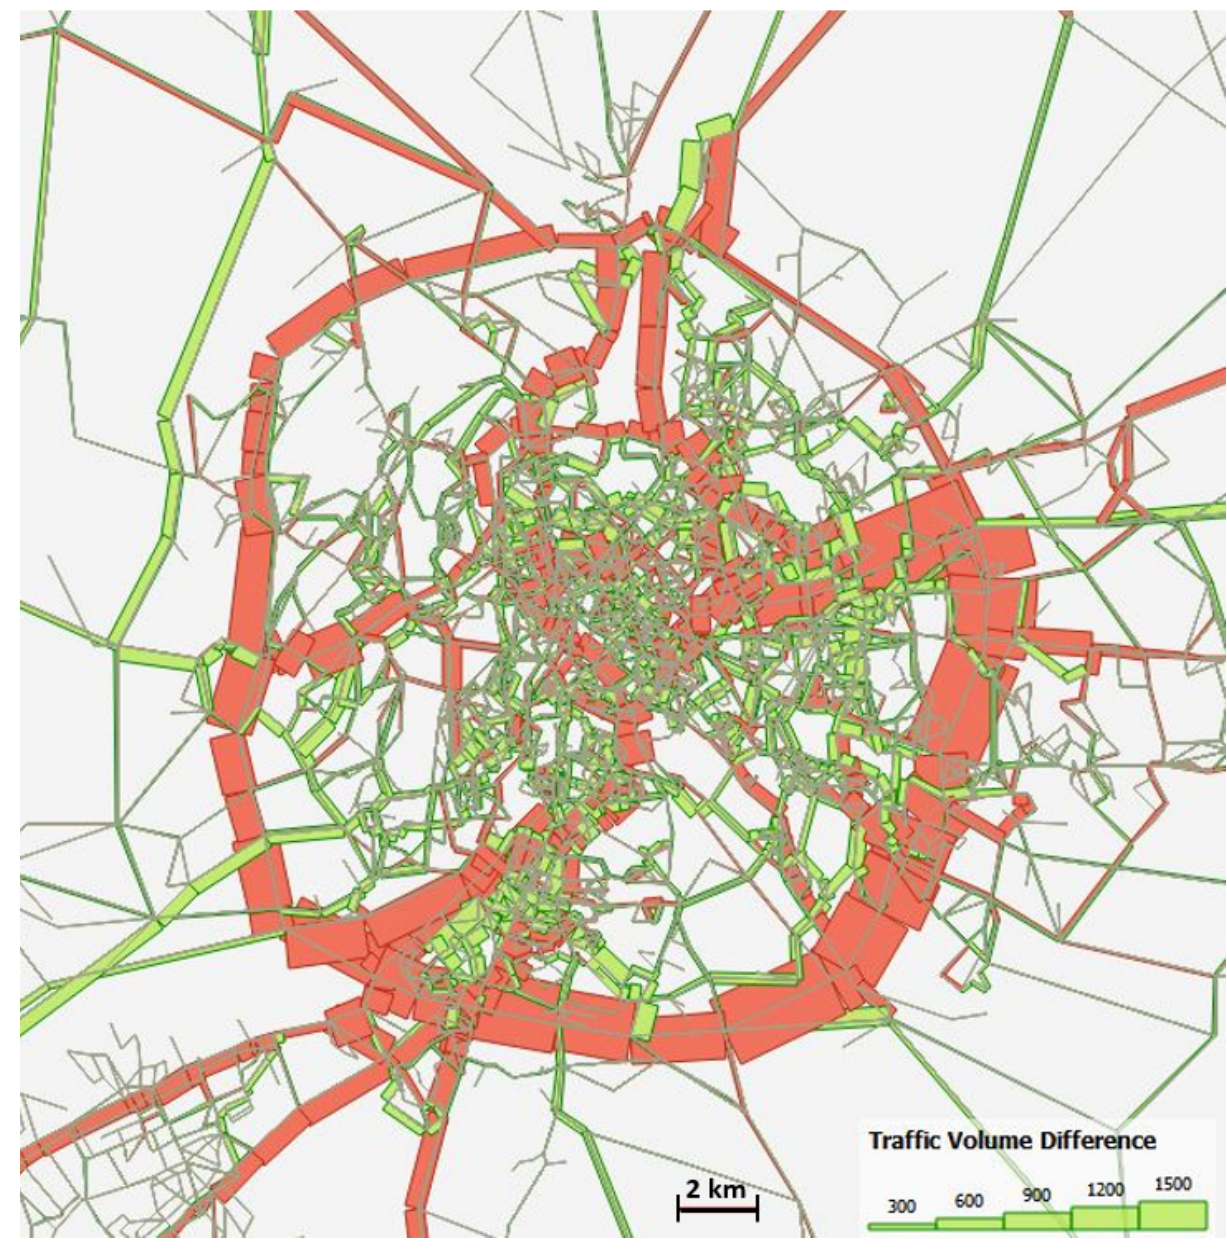
Figure 1: Traflc Volume difference